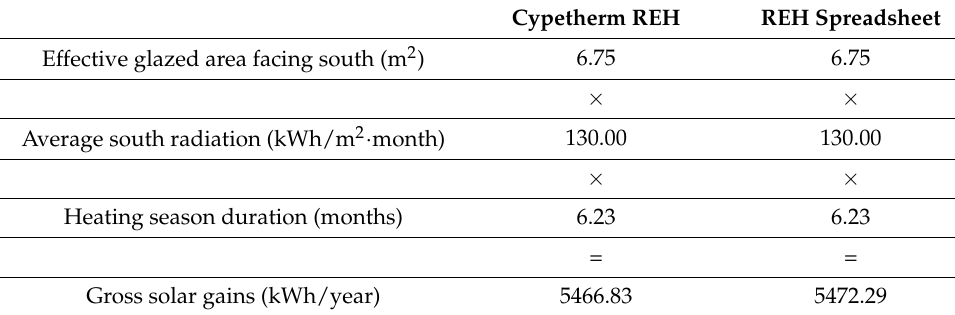
Table 7. Rounding differences between Cypetherm REH and the REH